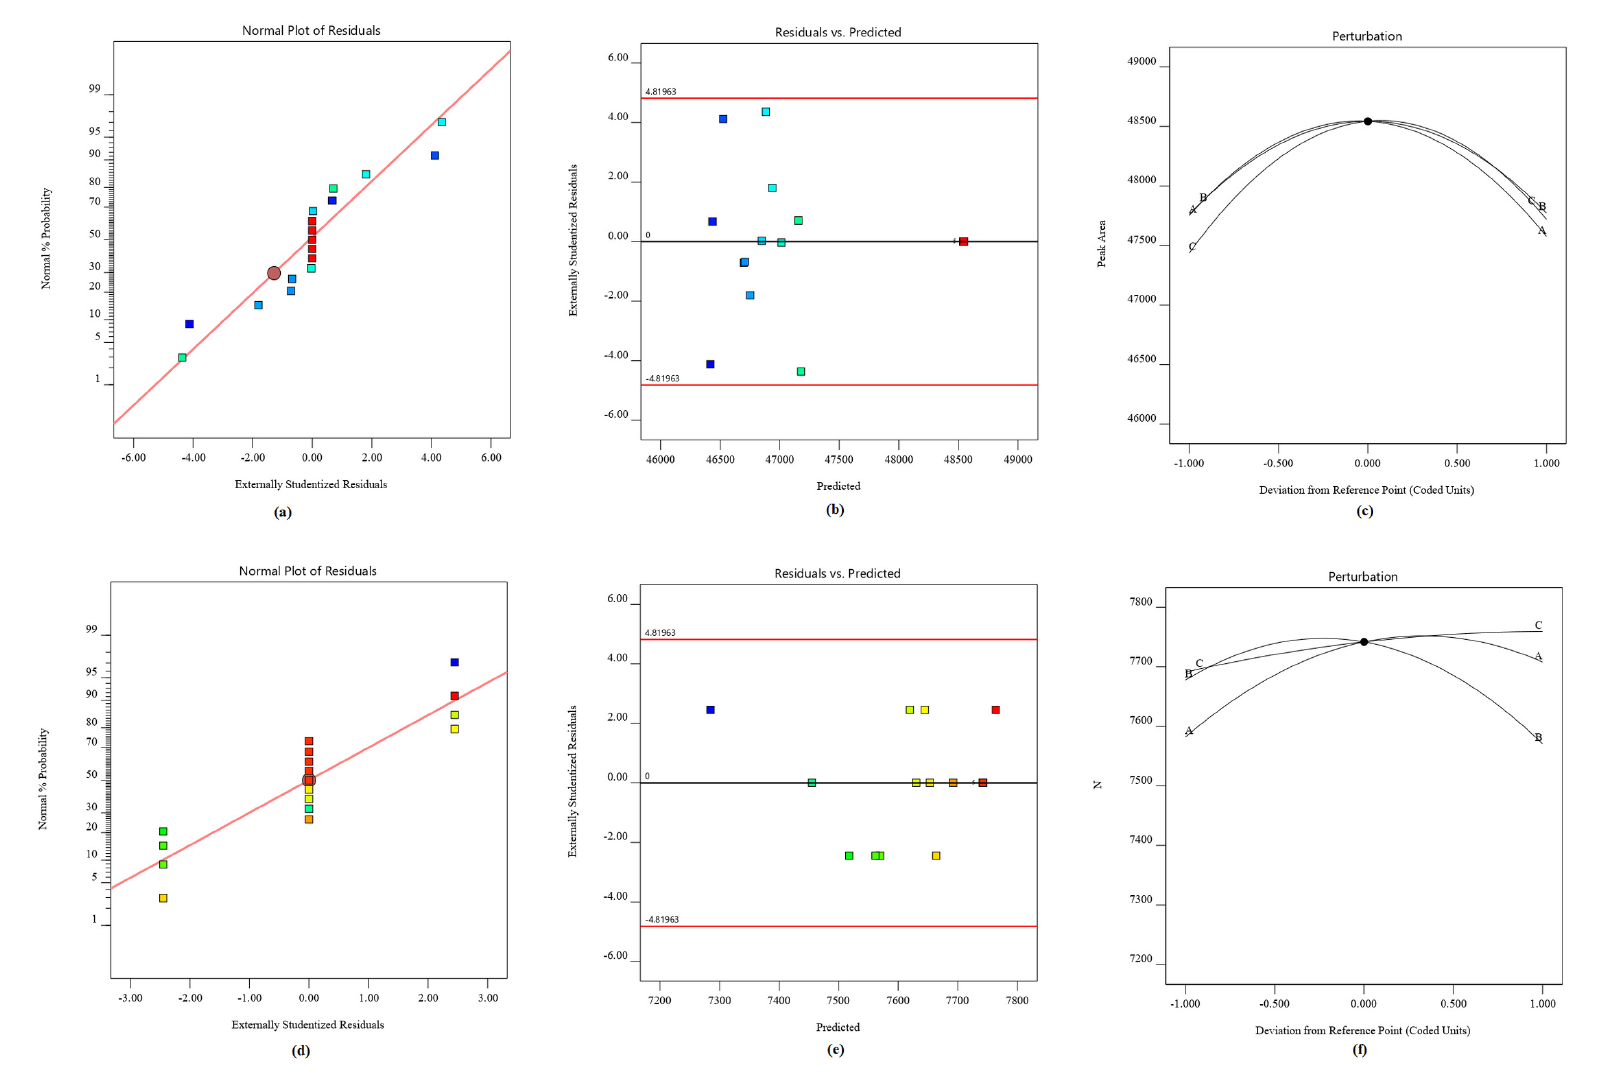
Figure 1. Box-Behnken design with peak area (a) Normal plot of residuals (b) Predicted vs Actual (c) Perturbation; with theoretical plate (d) Normal plot of residuals (e) Predicted vs Actual (f) Perturbation; with the theoretical plate to determine acetic acid content in potassium